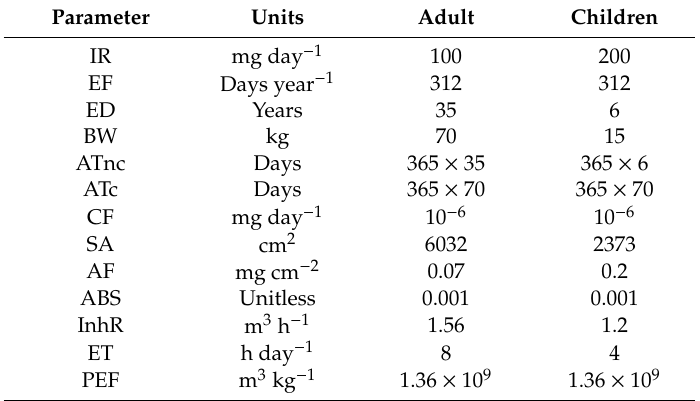
Table 3. Reference values adopted for the determination of chronic daily intake (CDI) based on USEPA [84]. Parameter